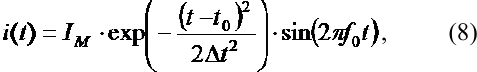
Figure 5 d isplays r espectively, t he tr ansient p lot o f t his signal a nd its frequency s pectrum. In p ractice, t he t ime interval range is defined from t min = 0 ns to t max = 14.218 ns with step ∆t = 0.1436